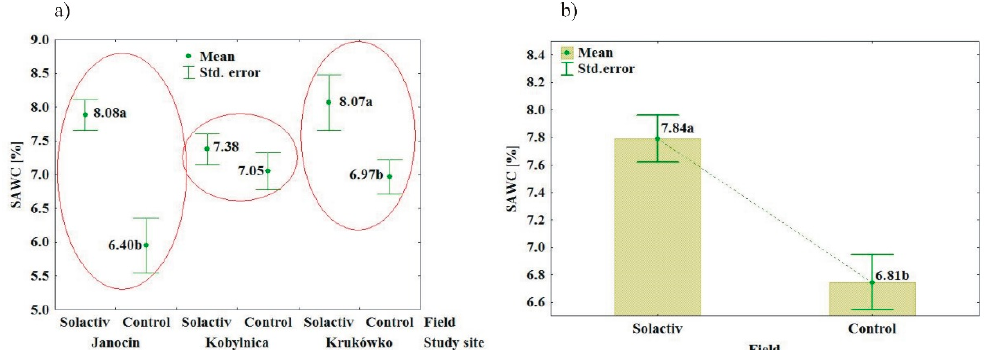
Figure 10. Soil SAWC as a ff ected by the tested conditioner. ( a ) means for individual study sites ( n = 10); ( b ) means for all study sites ( n = 30). Data were analyzed using one-way ANOVA. Mean values for conditioner and control followed by di ff erent letters are significantly di ff erent at p ≤ 0.05 according to Tukey’s HSD Test. The lack of letters indicates the lack of significance between means.